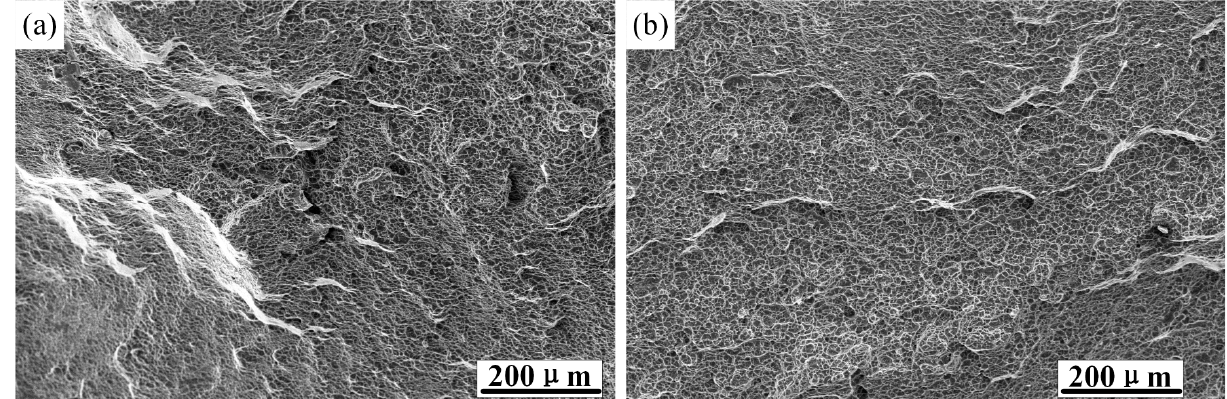
Figure 18. Tensile fracture morphology of a smooth specimen: ( a ) tensile fracture morphology at a test strain rate of 0.001 s − 1 ; ( b ) tensile fracture morphology at a test strain rate of 0.01 s − 1 .